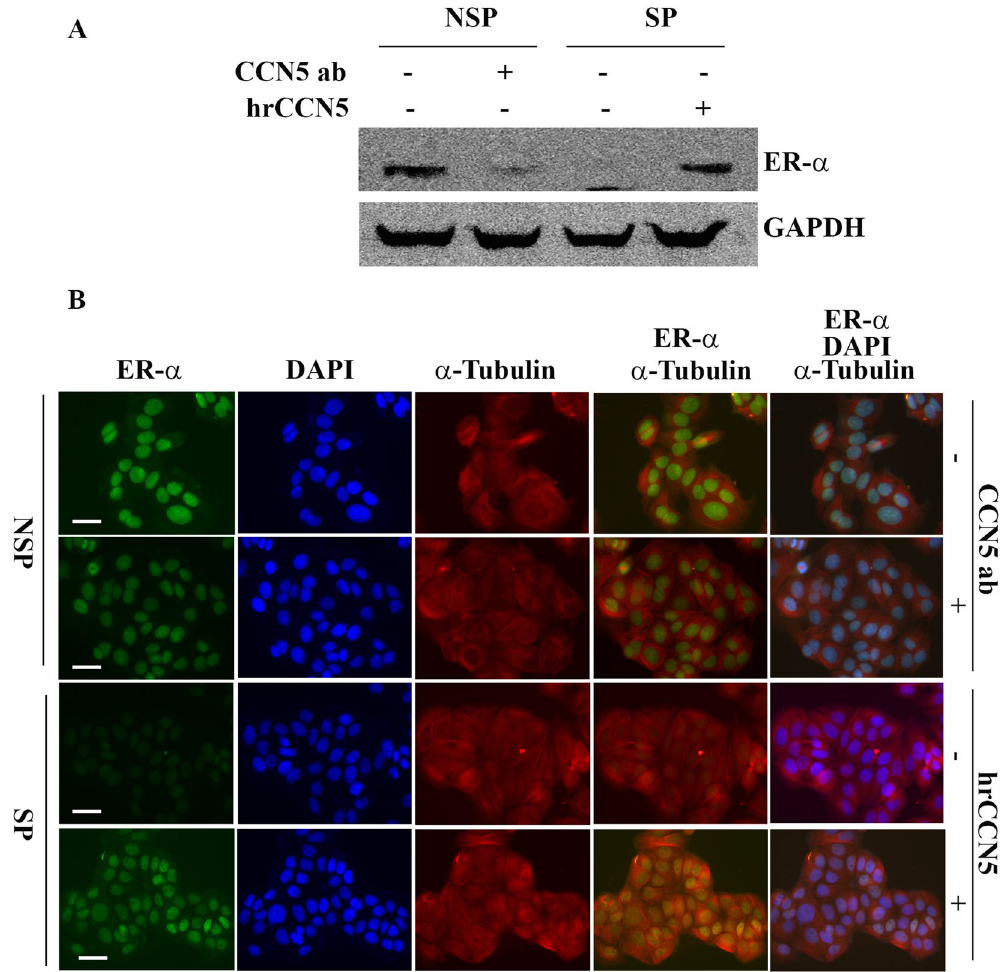
the expression of pER- α in NSP cells treated with anti-CCN5 antibody treatment (500 ng/ml) or PBS and SP cells treated with hrCCN5 protein (250 ng/ml) treatment or PBS for 72 h. GAPDH was used as a loading control. ( B ) Florescence microscopy for ER- α in NSP cells with or without CCN5 antibody (500 ng/ml) treatment and SP cells with or without hrCCN5 protein (250 ng/ml) treatment for 72 hours. ER- α was stained by indirect immunofluorescence, using a FITC-conjugated secondary antibody. α -Tubulin was stained using Alexa Fluor 555-conjugated antibody. First, second and third columns show staining for ER- α , DAPI and α -Tubulin respectively. Merge images of ER- α and α -Tubulin (fourth column) document lower expression of ER- α upon anti-CCN5 antibody treatment in MCF7-NSP cells and elevated ER- α expression after hrCCN5 protein treatment in MCF7-SP cells. Scale bar = 50 μ